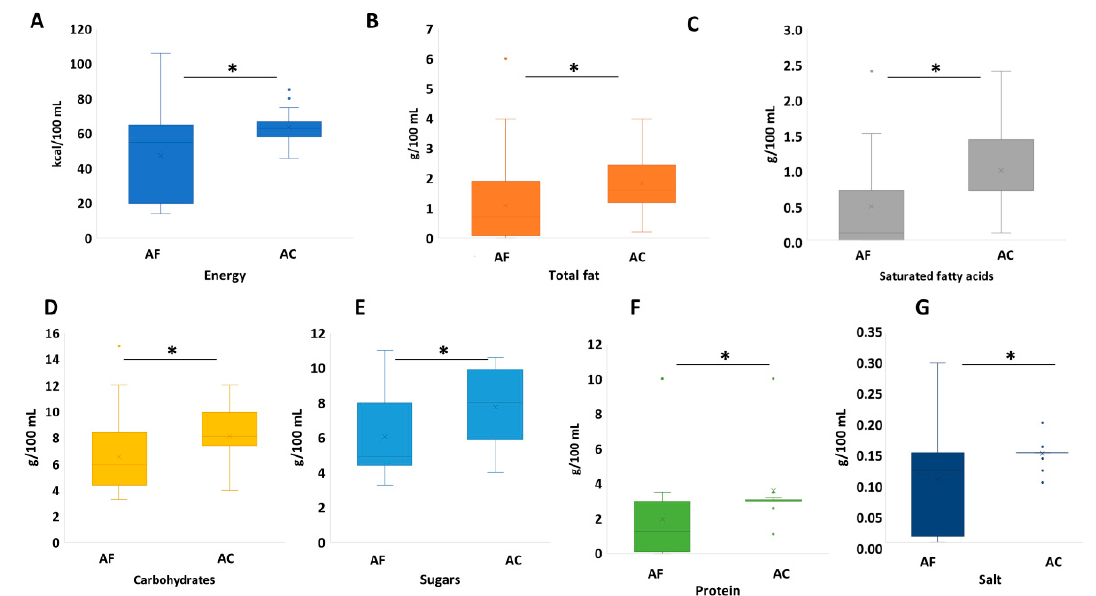
Figure 2. Nutritional profile of ready to drink beverages (RTDs) formulated with algae ( n = 20) vs. algae-free RTDs ( n = 51)